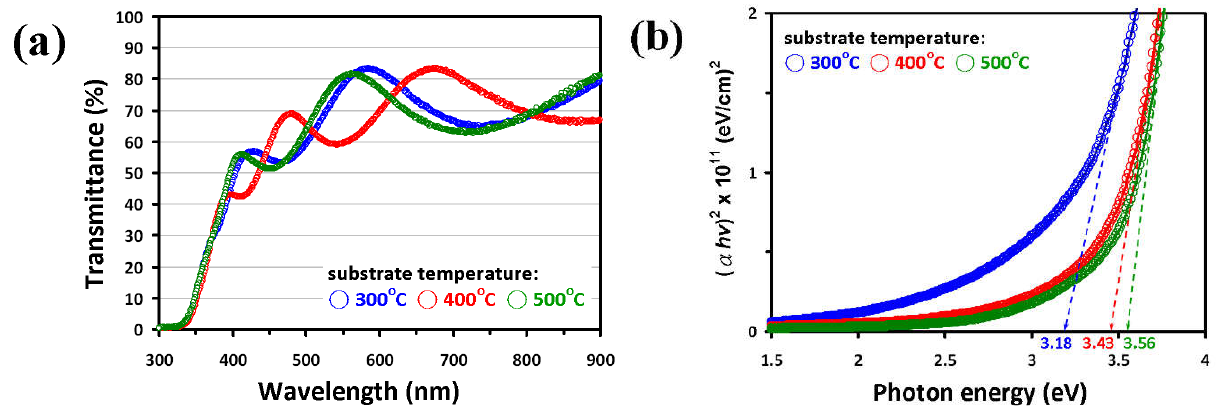
Figure 4. ( a ) UV-Vis transmittance spectra of NiO films with various substrate temperatures. ( b ) Plots of ( αhv ) 2 versus photon energy of NiO films with substrate temperatures and the evaluated E g values of NiO films are shown.